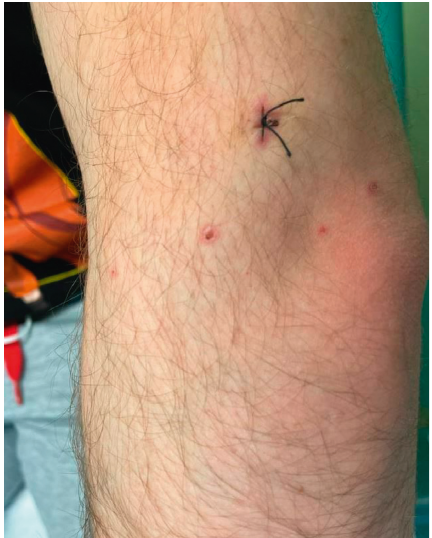
Figure 7: Maculopapular lesions on the right knee.